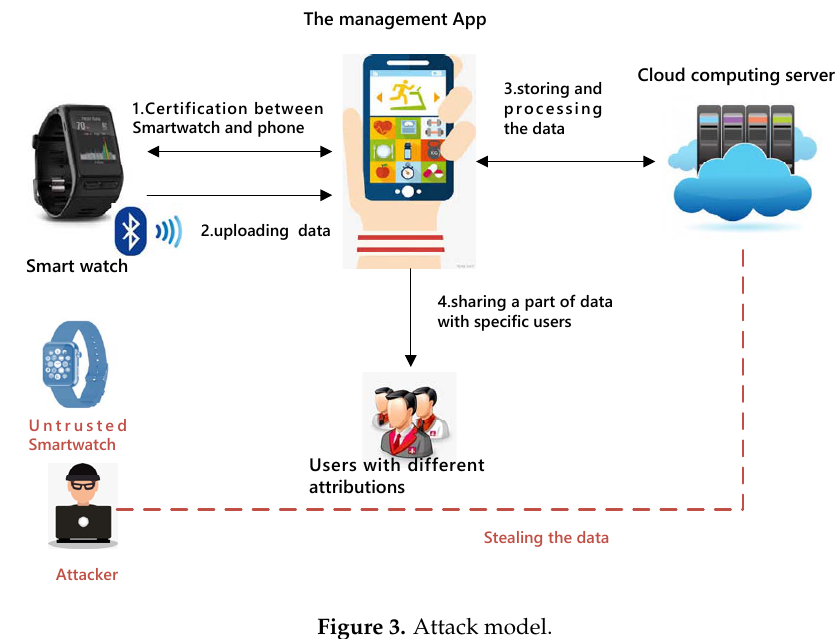
Figure 3. Attack